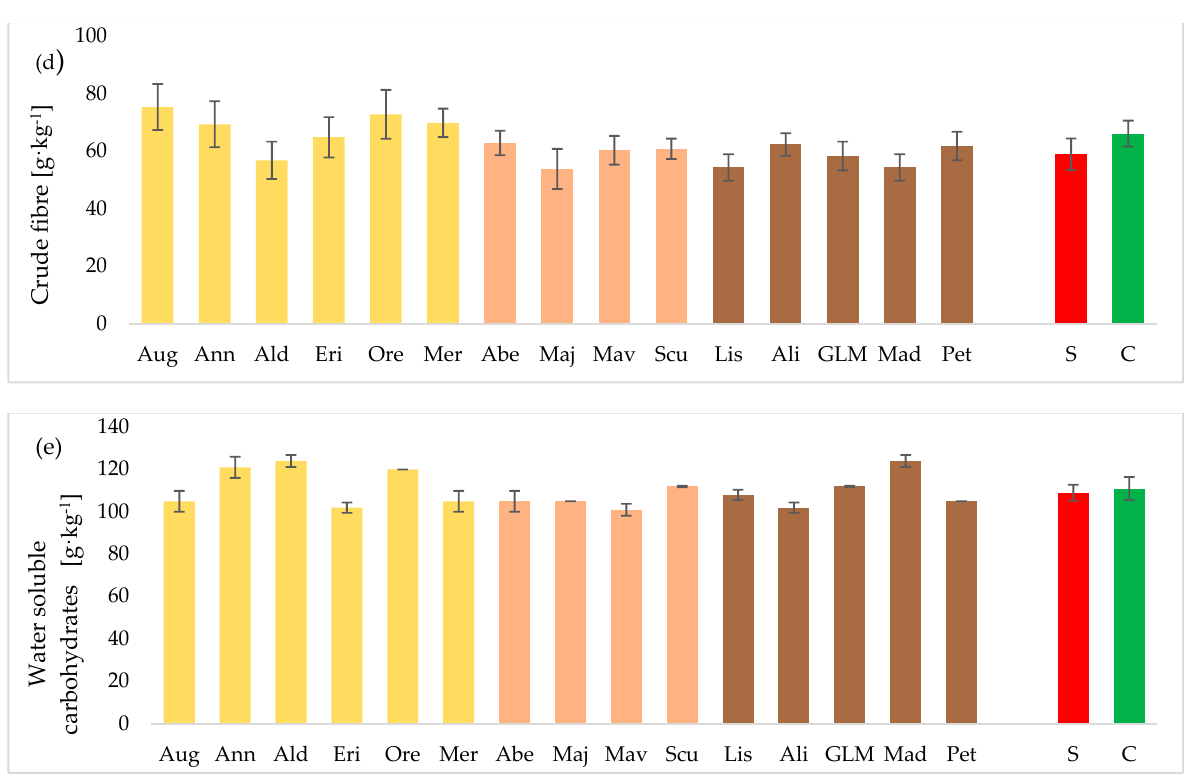
Figure 4. The effects of cold stress (n = 15) and cultivar (n = 2) treatments on chemical composition of seeds: content of crude protein ( a ), crude fat ( b ), crude ash ( c ), crude fibre ( d ), water soluble carbohydrates ( e ). Cultivars: Augusta (Aug), Annushka (Ann), Aldana (Ald), Erica (Eri), Oressa (Ore), Merlin (Mer), Abelina (Abe), Maja (Maj), Mavka (Mav), Sculptor (Scu), Lissabon (Lis), Aligator (Ali), GL Melanie (GLM), Madlen (Mad), Petrina (Pet)); EC—very early and early cultivars, MC—medium–early cultivars, LC—late and very late cultivars. Different lowercase letters indicate significant difference between cultivars, different uppercase letters—between treatment (cold stress (S) and control (C)) according to the Tukey test ( P = 0.05); ±SD.